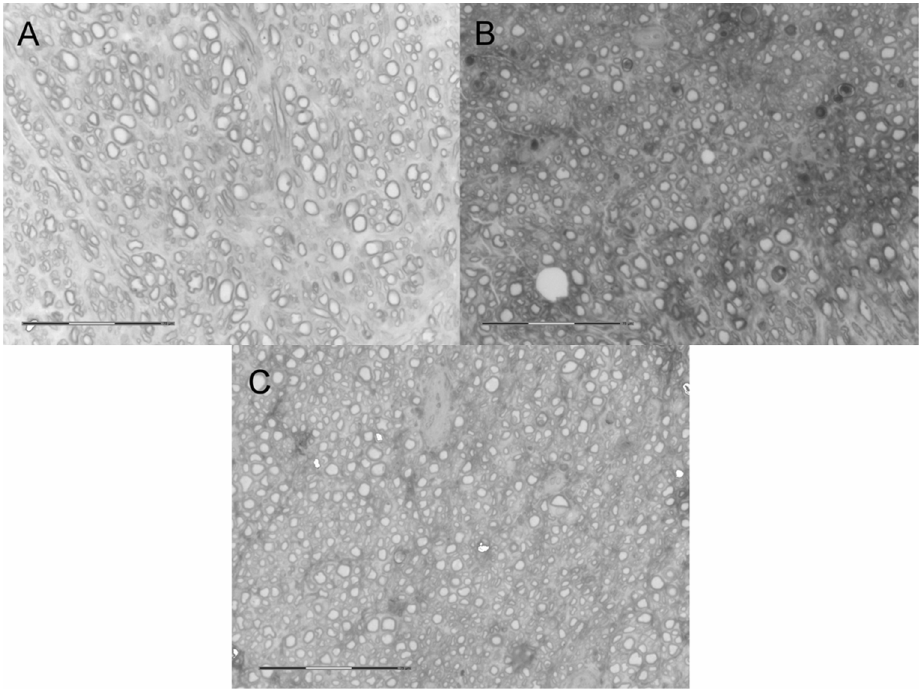
Figure 11. Weigert-Pal staining images in of nerve sections (800×, grayscale). ( A ) Autograft group; comparing to other groups, there is a lower density of fibers, which are relatively larger and have a thicker myelin sheath. ( B ) P(LLA-CL)-COL-PANI conduit group—fibers are more densely arranged, and there are a larger number of artifacts and inclusions. ( C ) P(LLA-CL)-COL-PANI conduit with ASC group—density of nerve fibers is comparable with Group B, there are less inclusions and scar tissue.